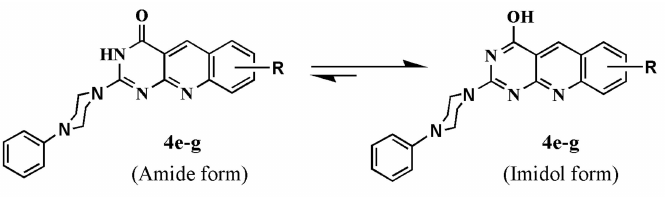
Figure 5. The amide-iminol tautomerism for compounds 2-deoxo-2-(4-phenylpiperazin-1-yl)-5- deazaalloxazines ( 4e – g